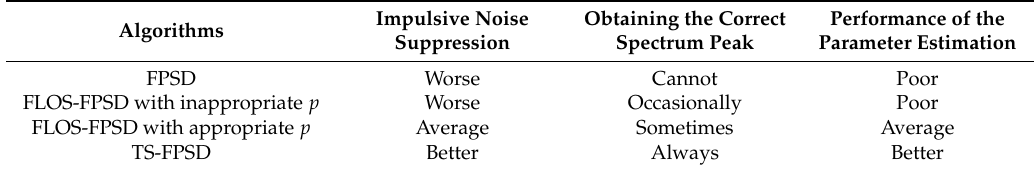
Table 1. A comparison of the three algorithms for impulsive noise suppression.